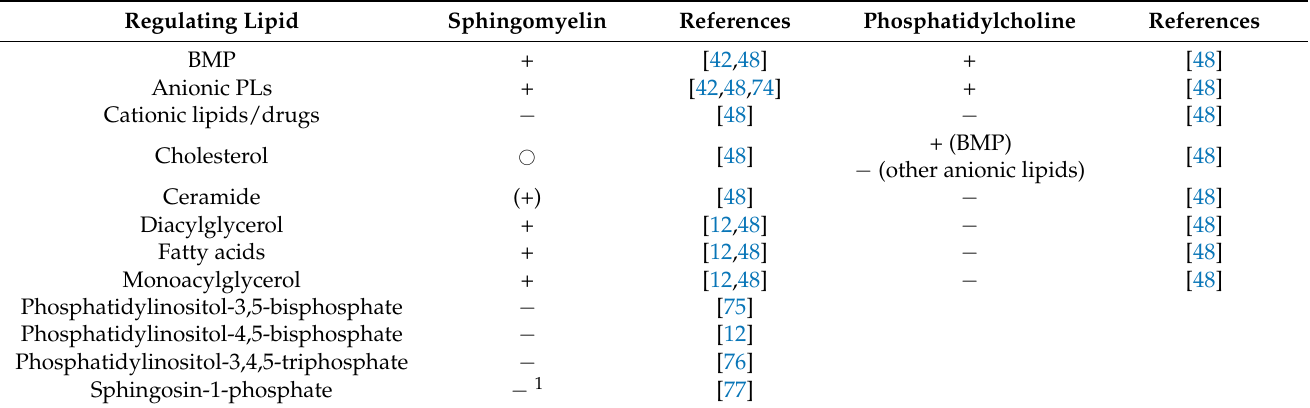
Table 1. Regulation of PL cleavage activity of ASM by